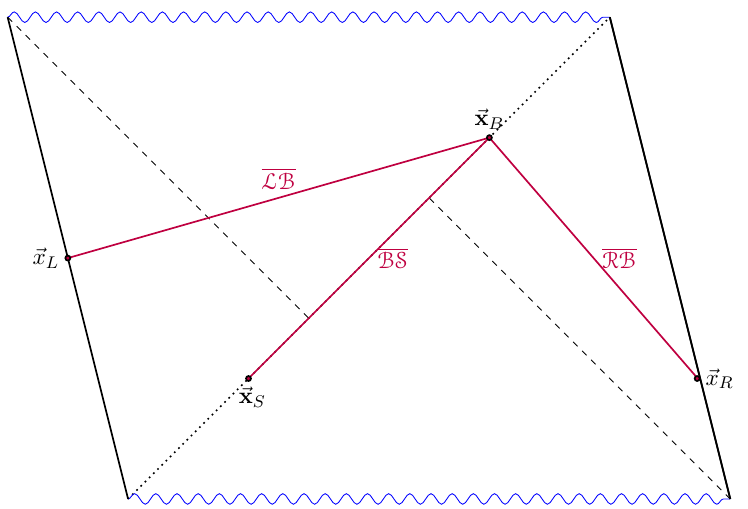
Figure 4 . A sketch of the massive particle worldlines used for computing the chaos correlator from the bulk AdS geometry, depicted on the shockwave Penrose